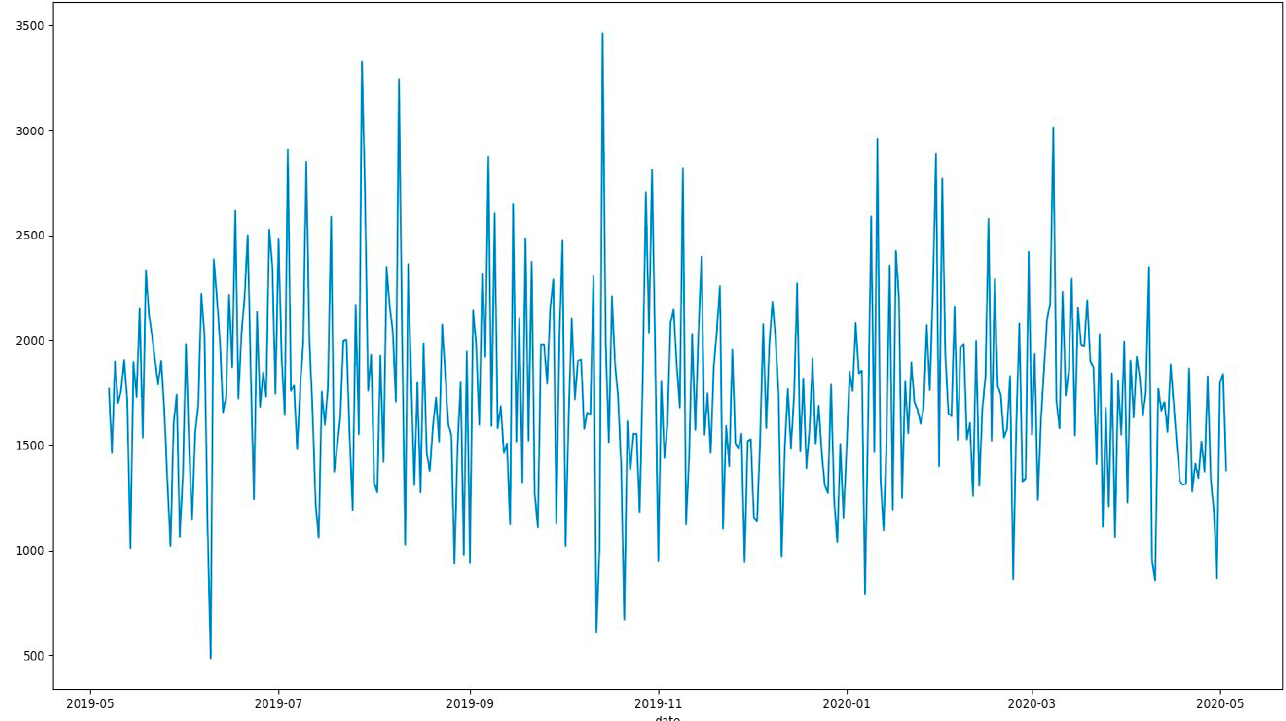
Figure 2. An absolute activity graph example of the far-right VKontakte community.